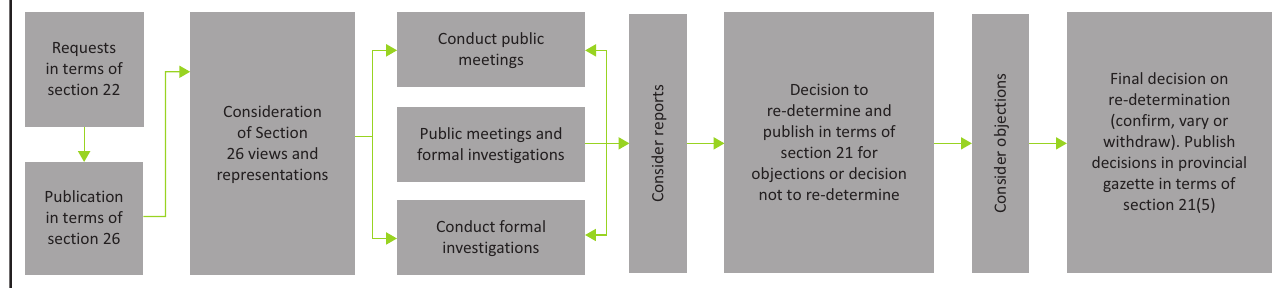
FIGURE 2: Municipal boundary redetermination